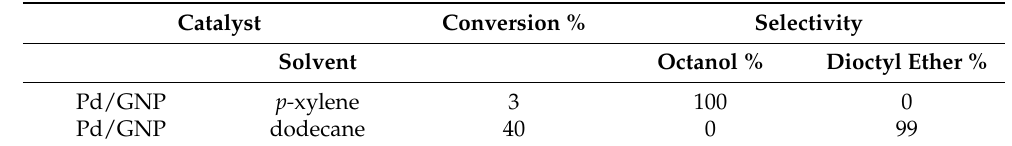
Table 9. Results obtained in octanal hydrogenation in different solvents. Reaction occurred at 150 °C, 20 bar of H 2 and Pd:octanal molar ratio of 1:500. Conversion has been calculated after 2 h.